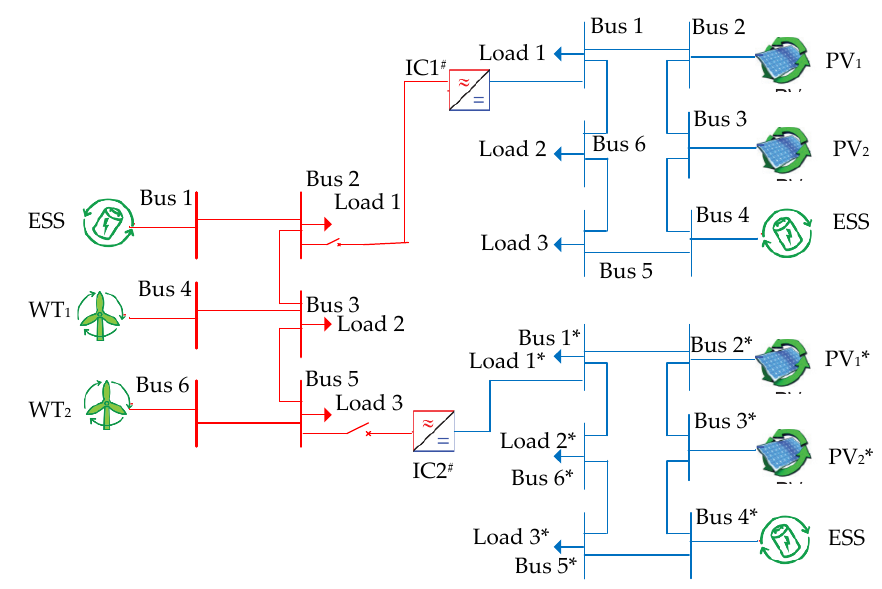
Figure 8. Multi-DC subgrids IHMG test system in mode 5.